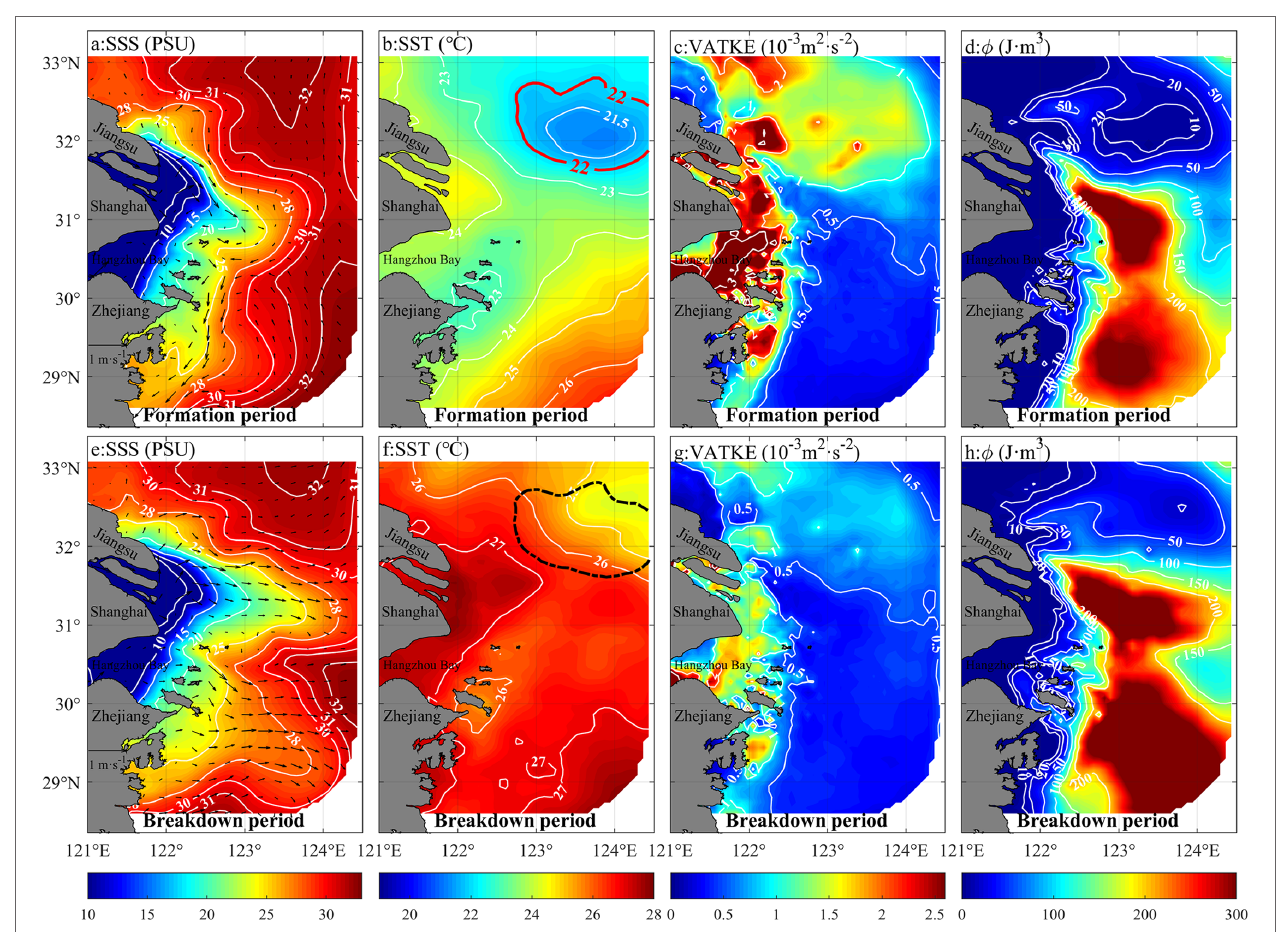
FIGURE 7 | Spatial patterns of model-simulated average SSS (A, E) , SST (B, F) , vertical-averaged turbulent kinetic energy (VATKE; C, G ), and potential energy anomaly (Ø; D-H ) during the formation period of July 3–19, 2015 (A-D) and breakdown period of July 20–31, 2015 (E-H) . Black arrow in panels (A, E) represents surface flow, black dash line in panel (F) indicates the original